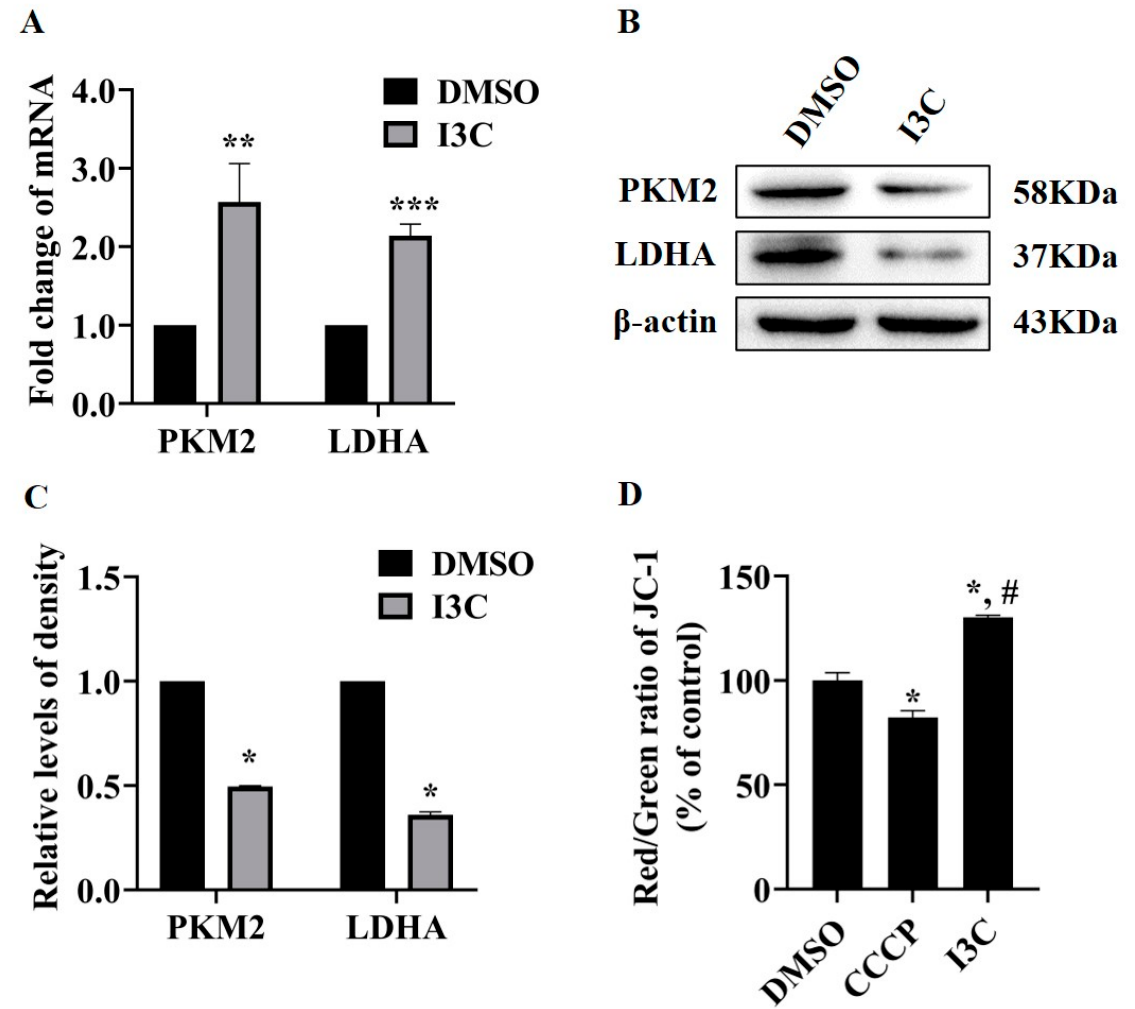
Figure 2. The effects of I3C treatment on the expression of glycolysis-related genes and mitochondrial function in HepG2 cells. ( A ) Measurement of the mRNA levels (** p < 0.01 vs. DMSO, *** p < 0.001 vs. DMSO) and ( B ) protein levels of glycolysis-related genes after DMSO (vehicle) and I3C (200 µ M for 12 h) treatments; ( C ) Densitometric analysis for blots shown in ( B ). * p < 0.05 vs. DMSO; ( D ) Effects of I3C on MMP. The mitochondrial uncoupler CCCP was used as a control. * p < 0.05 vs. DMSO, # p < 0.05 vs. CCCP.